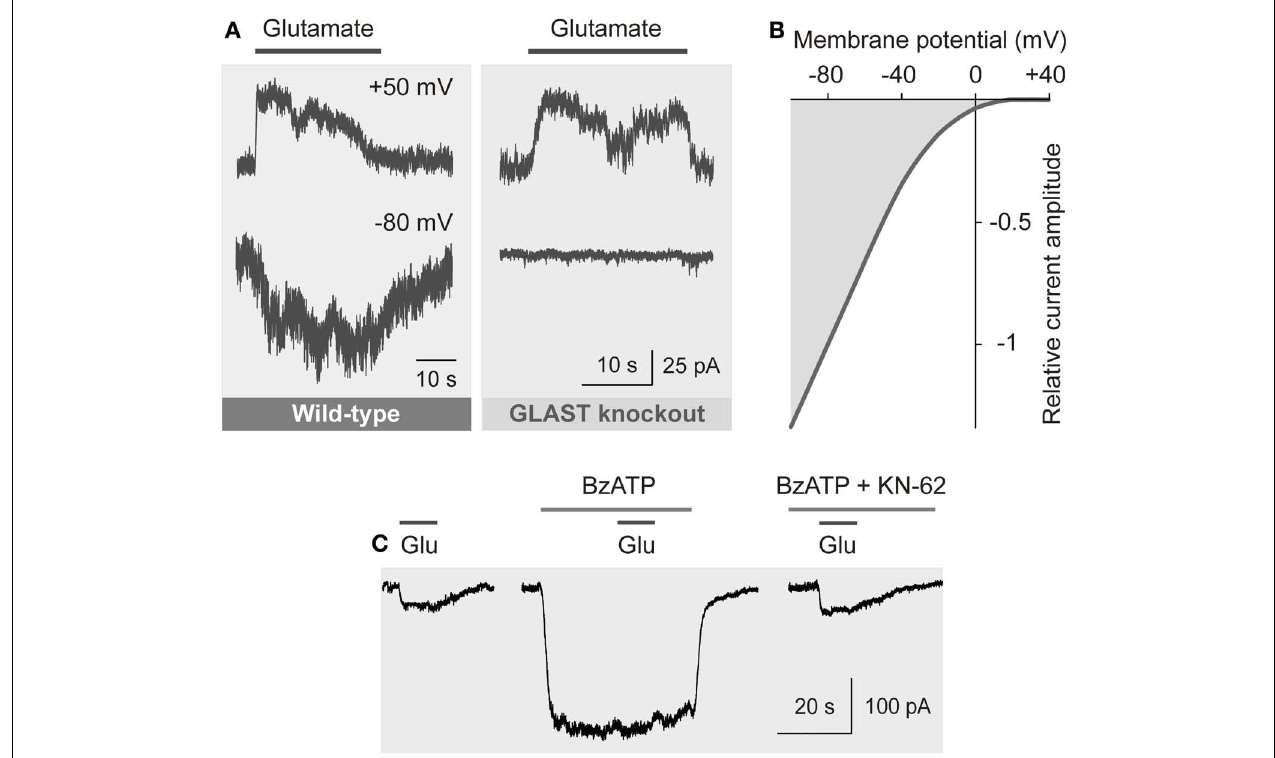
FIGURE 4 | Electrogenic glutamate transport in Müller cells. Whole-cell records of membrane currents were made in freshly isolated cells. (A) Administration of glutamate (1mM) to a Müller cell of a wild-type mouse evoked inward currents at − 80mV, and outward currents at + 50mV.The inward currents were mediated by the sodium-dependent glutamate uptake, while the outward currents were mediated by the anionic conductance of the glutamate transporter. (The amplitude of the anionic conductance was increased by replacing extracellular chloride with thiocyanate.) In a cell of a GLAST knockout mouse, glutamate did not evoke inward currents, whereas outward currents remained.The absence of inward currents may suggest that at the resting membrane potential of murine Müller cells the electrogenic glutamate uptake is mediated by GLAST.The presence of the chloride conductance may suggest that EAAT5 (which has a large